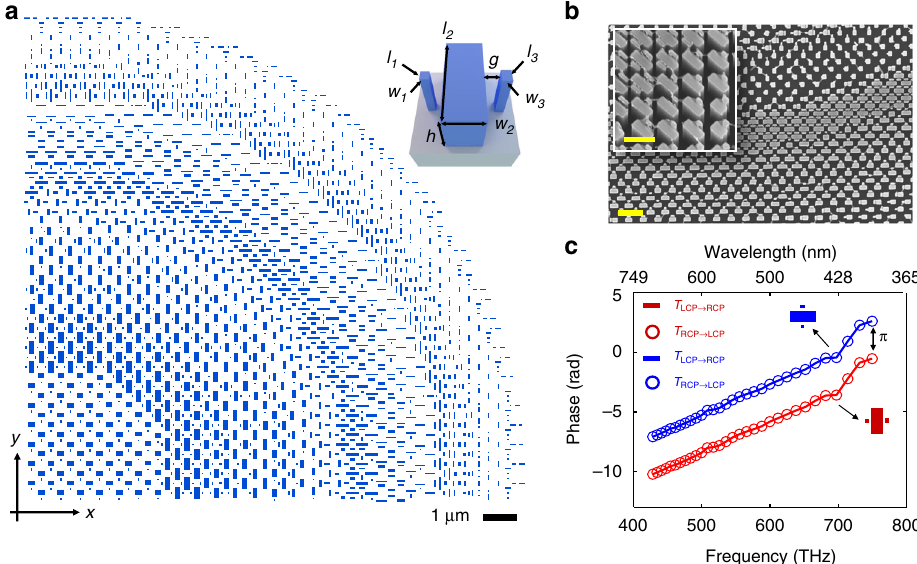
Fig. 1 Principle behind polarization-insensitive and achromatic metalens. a Layout of a quadrant of the metalens. It has a NA of 0.2 and a diameter of 26.4 μ m. The inset shows a schematic diagram of its constituent elements. Each element comprises TiO fi ns with the same height h = 600 nm. 2 nano These elements are spaced equally with a lattice constant of 400nm. b A scanning electron microscope image of a part of the fabricated metalens. Scale bar: 1 μ m. The inset shows a magni fi ed and oblique view of the nano fi ns. Scale bar: 500 nm. c Simulated phase shift of the component of the transmitted electric fi eld with polarization orthogonal to the incident circularly polarized light. The legend, for example T LCP → RCP , represents the phase of RCP transmitted light under LCP incidence. The blue and red colors show the same element, consisting of three nano fi ns, oriented along horizontal and vertical directions, respectively. The nano fi n parameters ( w 1 , l 1 , w 2 , l 2 , w 3 , l 3 , g ) = (50, 50, 170, 370, 50, 90, 60) in nanometer units. The element shows identical phase under both RCP and LCP illuminations. Note that for a given incident circular polarization, a 90-degree rotation introduces a π phase shift without affecting group delay (slope) and group delay dispersion